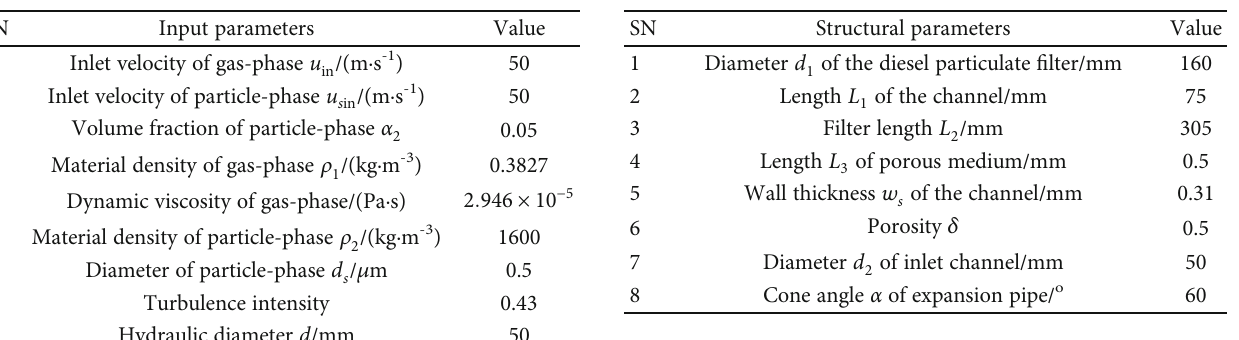
Table 1: Numerical simulation of the input parameters. Table 2: Structural parameters of diesel particulate fi